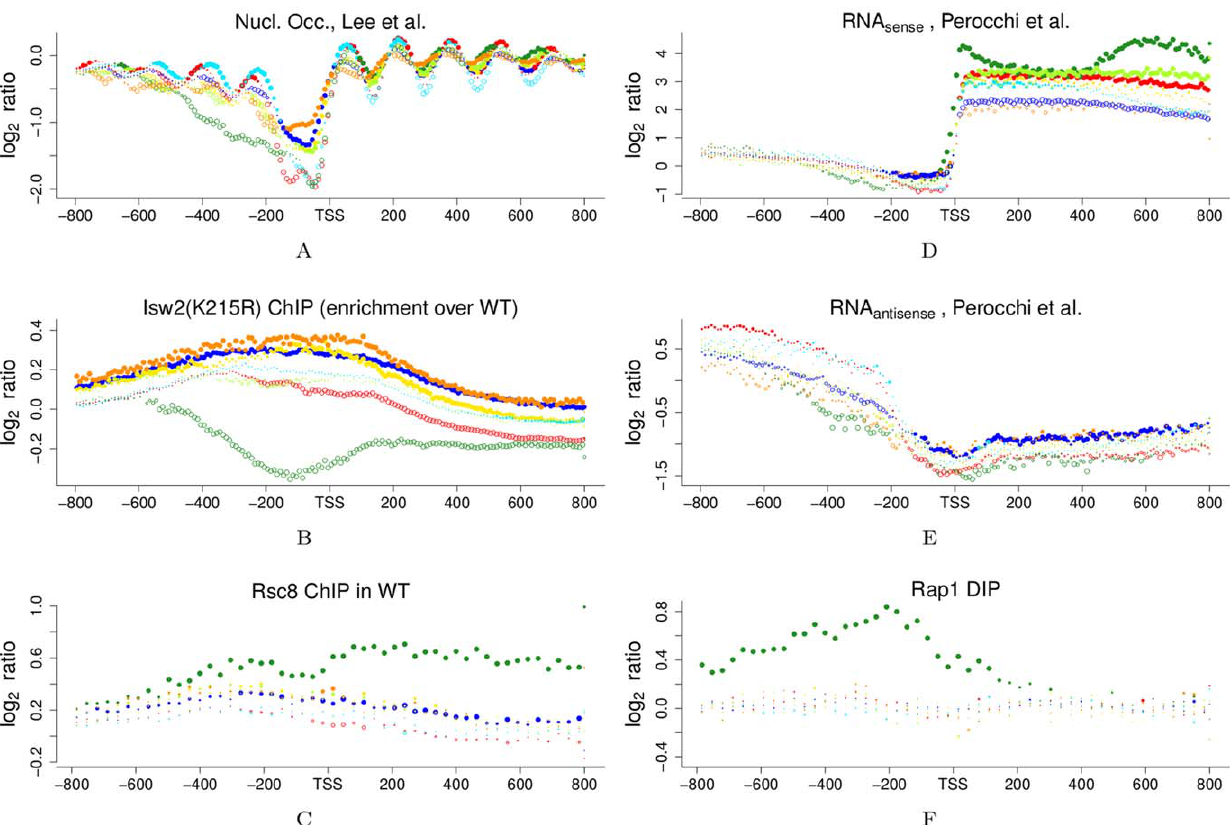
Figure 5. Statistical DNA profiles (SDP) of nucleosome occupancy, Isw2(K215R) ChIP, Rap1p DIP, Rsc8p ChIP & transcriptome tiling array datasets. SDP were constructed as desribed for Figure 4. Figure 1C provides a color legend. Only results for consensus clusters are shown here, see Figure S11 for background clusters. Nucleosome occupancy data from 5A: tiling array dataset in 4 bp resolution [36]; 5B: Isw2(K215R) ChIP- tiling array data in 5 bp resolution [40]. 5D: transcriptome tiling array data in 8 bp resolution [68] on the sense strand; 5E: same as 5D but for the signal from the antisense strand. 5C & 5F: data are from [41] with resolution & SDP bin size: 32 bp; 5C: Rsc8-TAP ChIP-chip data in wildtype cells. 5F: Rap1 DIP-chip data ( in vitro ‘‘DNA immunoprecipitation-chip’’ of genomic DNA by